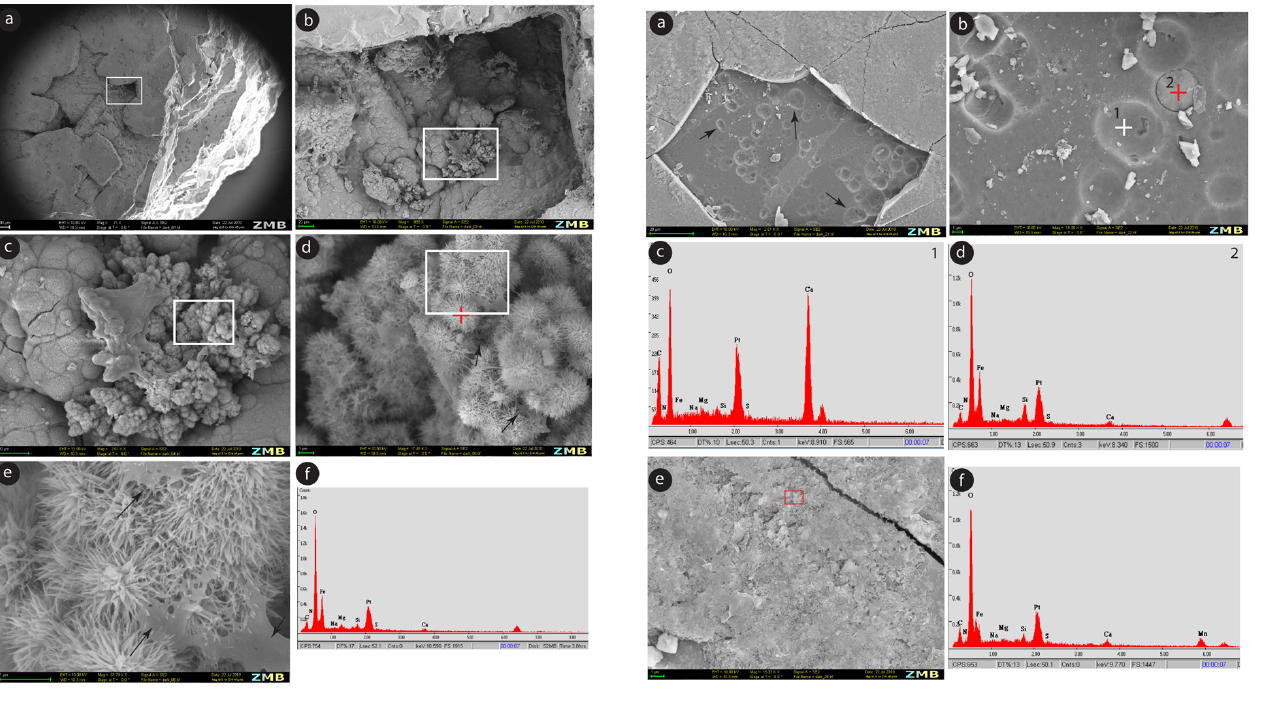
Fig. 10. Secondary electron images of the dark-brown crusts: (a) iron oxides are located in the depressions within calcite crystals; (b, c) globular structures with a size ranging from a few microns to 20 | mum; (d, e) spherical bodies are composed of acicular needles that have a radial arrangement. They display a close association with EPS (arrows), as the needles are within or below EPS; (f) elemental analysis showing that Fe and O are the main components of these crusts and are associated with a small contribution of Mg and Si.